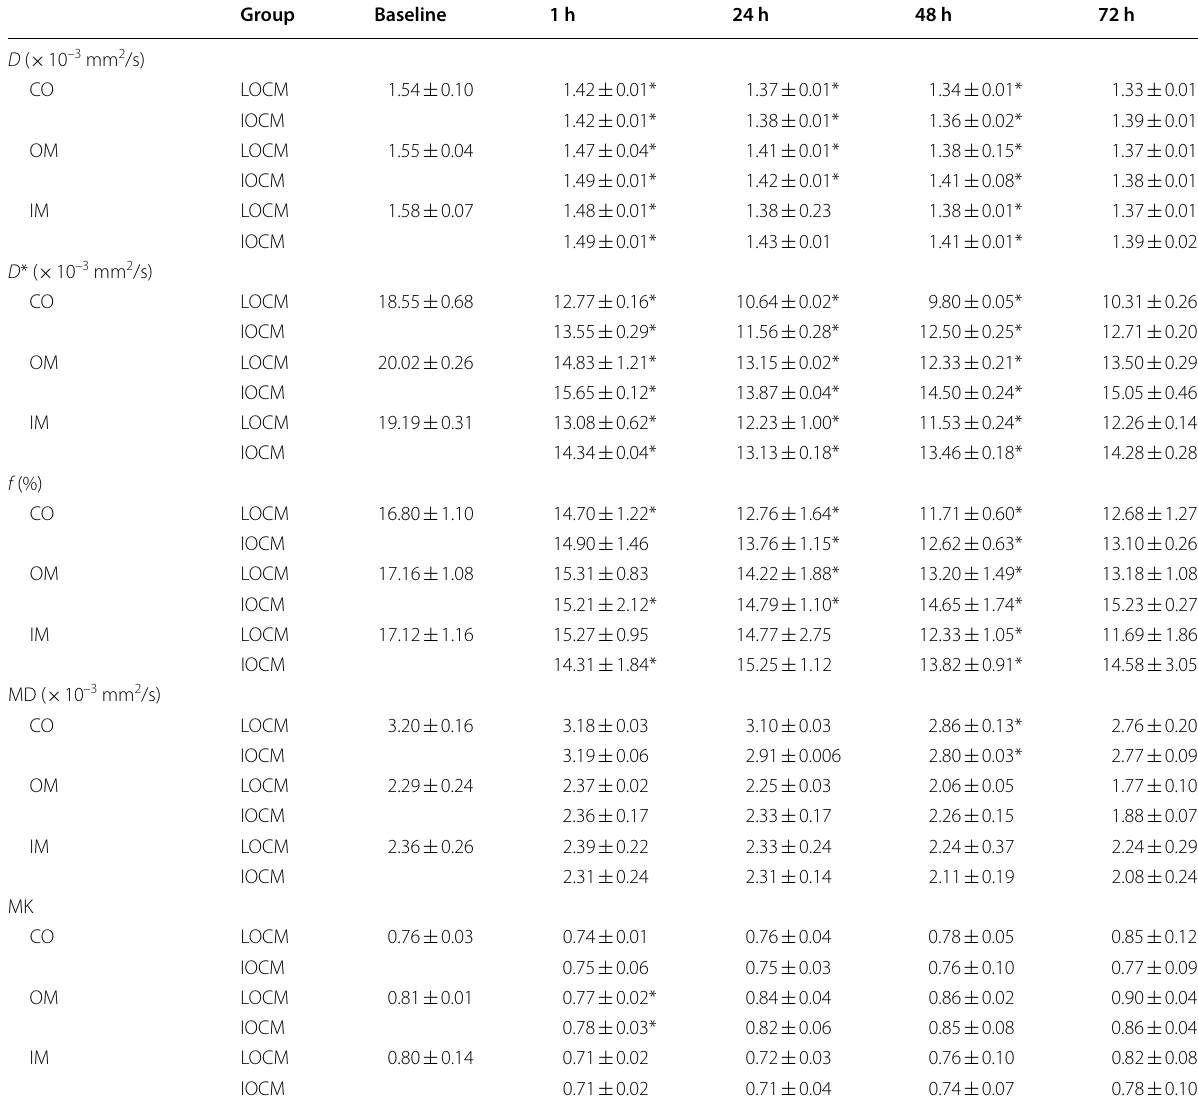
*Represents p < 0.05 versus baseline